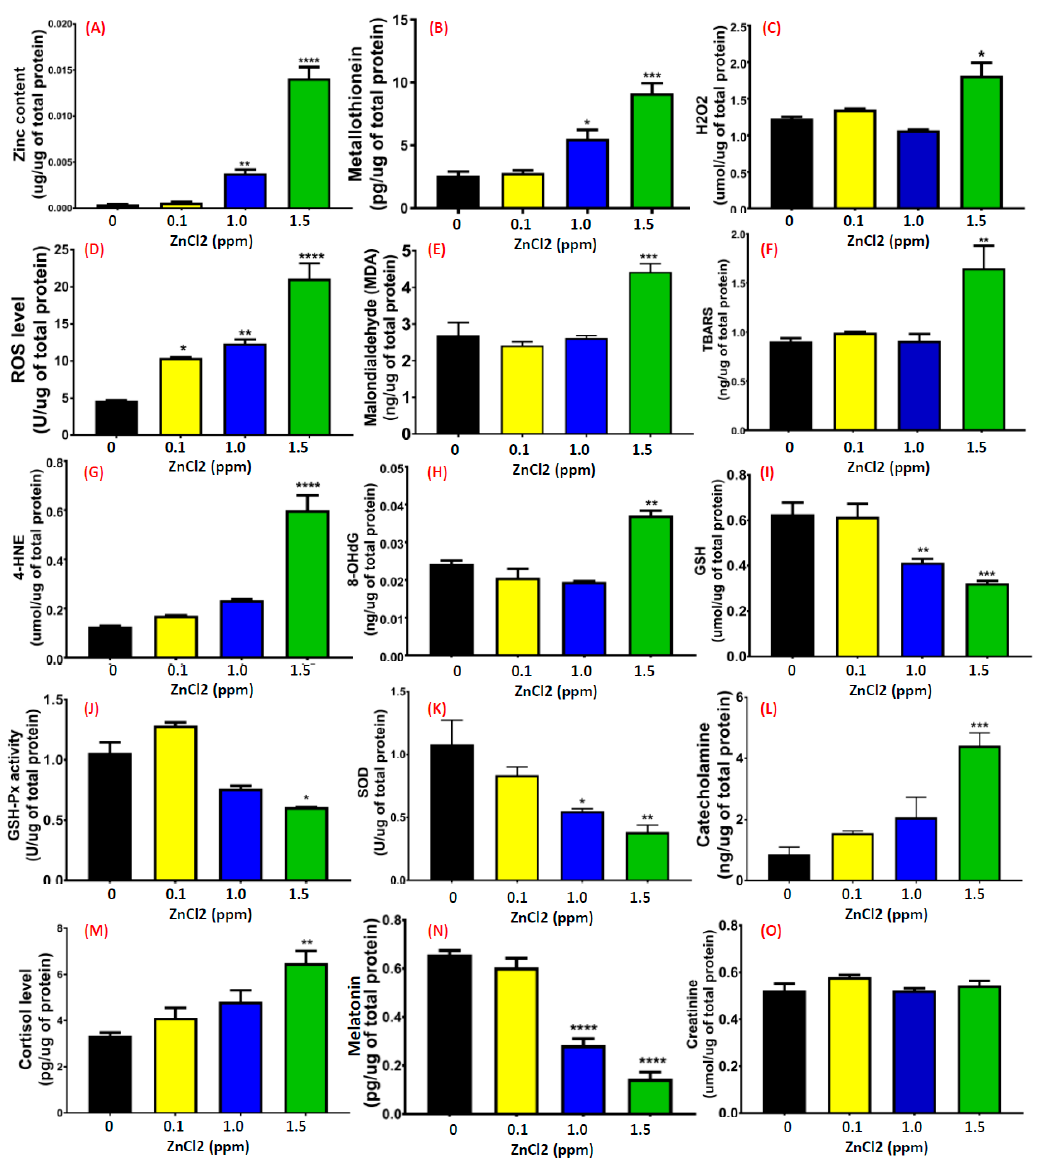
Figure 7. Detection of biochemical parameters in the brain. Enzymatic or ELISA-based methods were applied to detect the levels of ( A ) zinc ions, ( B ) metallothionein, ( C ) reactive oxygen species (ROS), ( D ) H 2 O 2 , ( E ) malondialdehyde (MDA), ( F ) thiobarbituric acid reactive substances (TBARS), ( G ) 4-hydroxynonenal (4-HNE), ( H ) DNA damage marker 8-hydroxy-2 ′ -deoxyguanosine (8-OH-dG), ( I ) glutathione (GSH), ( J ) GSH peroxidase (GSH-Px), ( K ) superoxide dismutase (SOD), ( L ) catecholamine, ( M ) cortisol, ( N ) melatonin, and ( O ) creatinine after treatment with various concentrations of ZnCl 2 . Data are represented as means ± SEM of four independent experiments. Statistical analysis was compared to control using a t -test (* p ≤ 0.05; ** p ≤ 0.01; *** p ≤ 0.001; **** p ≤ 0.0001).